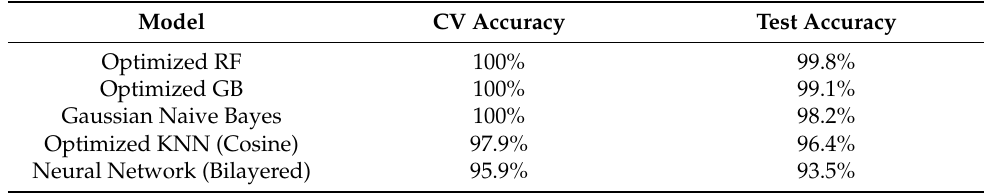
Table 1. Test accuracy of ML models with 18 features for